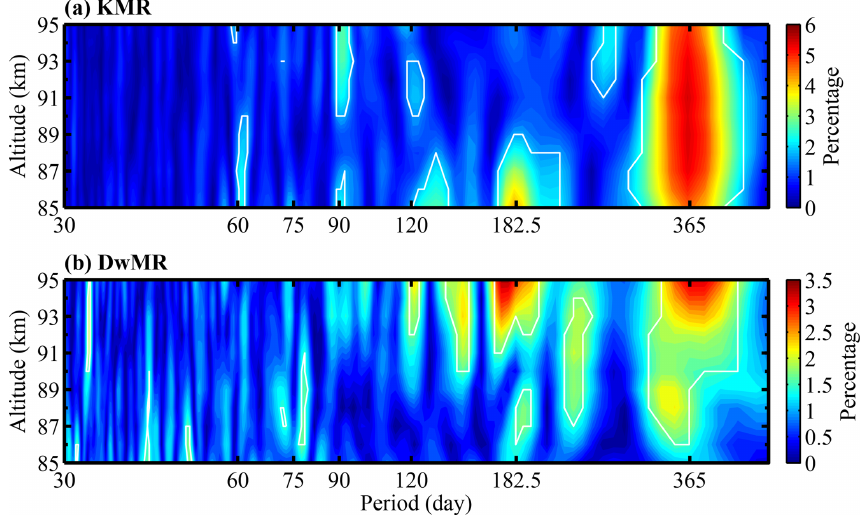
Figure 8. Same as Fig. 4 but for the KMR and DwMR daily mean relative densities at low